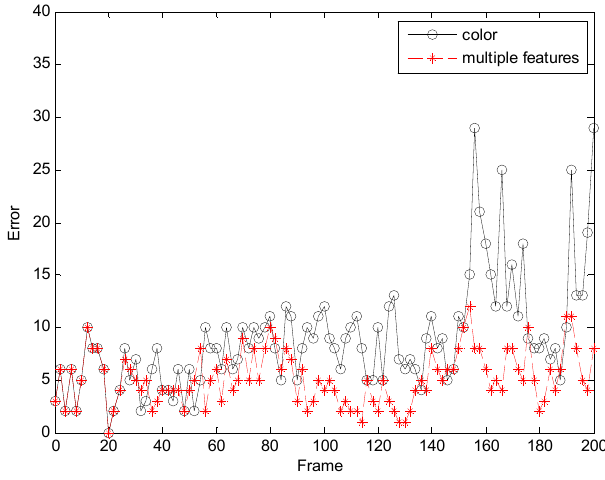
Figure 9. The RMSE comparison corresponding to background change.